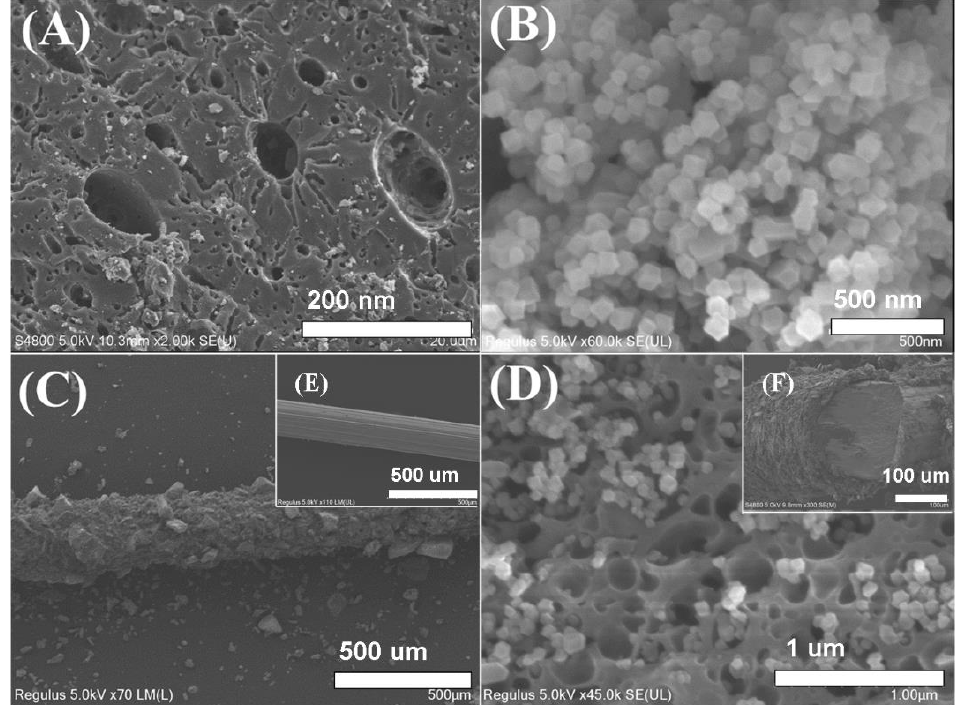
Figure 1. Scanning electron micrograph of ( A ) CA, ( B ) ZIF-8, ( C ) ZIF-8/CA -coated fiber at 70×, and ( D ) ZIF-8/CA coating at 45,000×. In the inner inset, ( E ) naked wire fiber, and ( F ) cross-section of coated fiber.